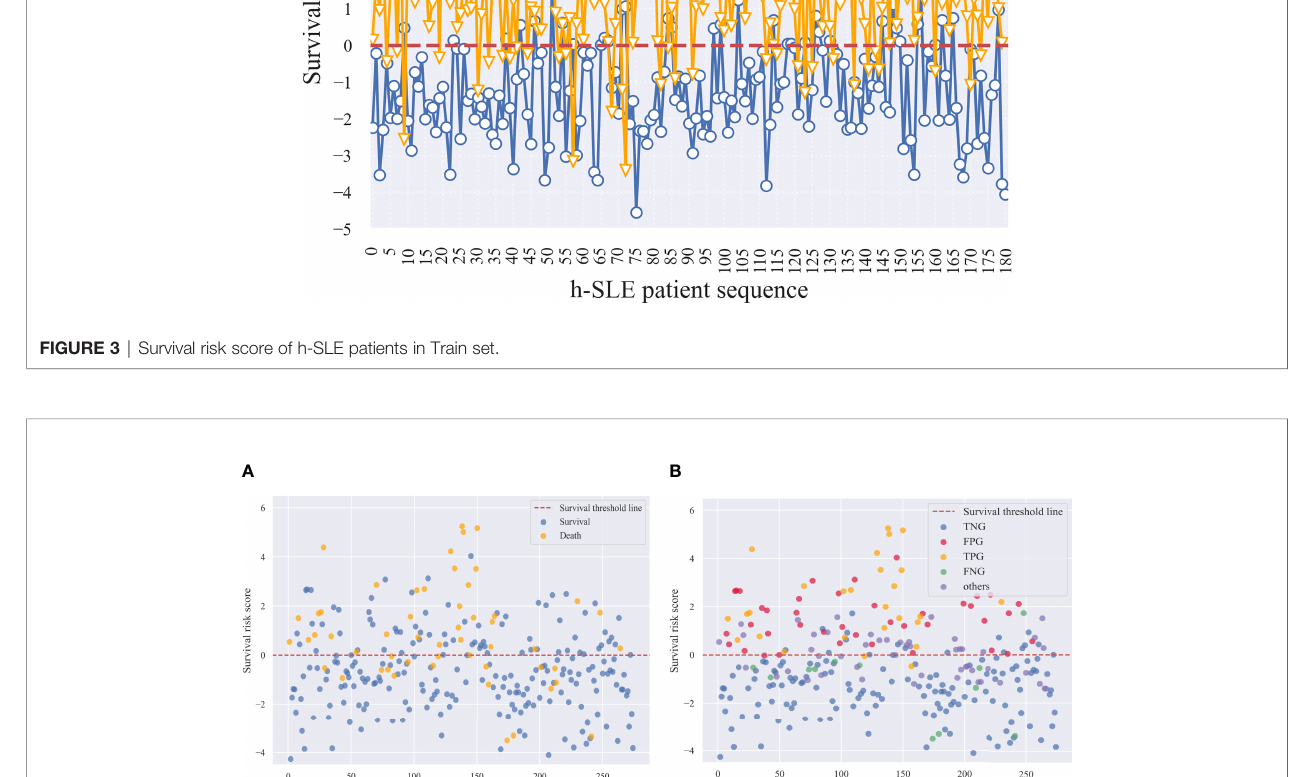
FIGURE 4 | Survival risk scores of h-SLE patients in Test set. (A) Survival and death patients in test set; (B) Internal validation group of survival outcome prediction model. TNG, true negative group; FPG, false positive group; TPG, true positive group; FNG, false negative group.